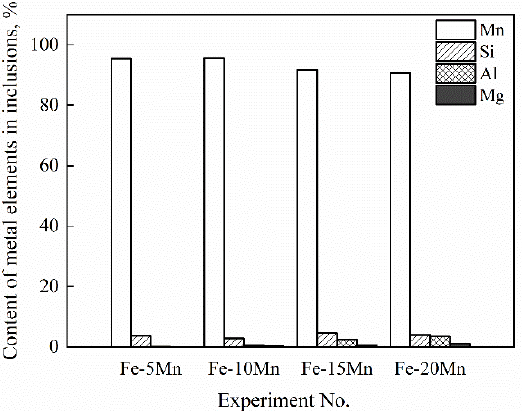
Figure 5. Percentage of inclusion types.